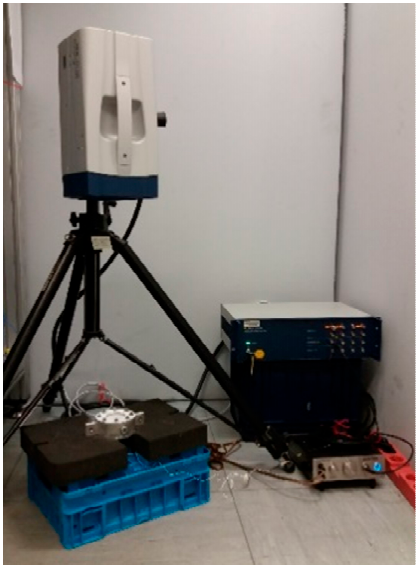
Figure 2. Measurement setup with a laser vibrometer and the fixture placed on foam